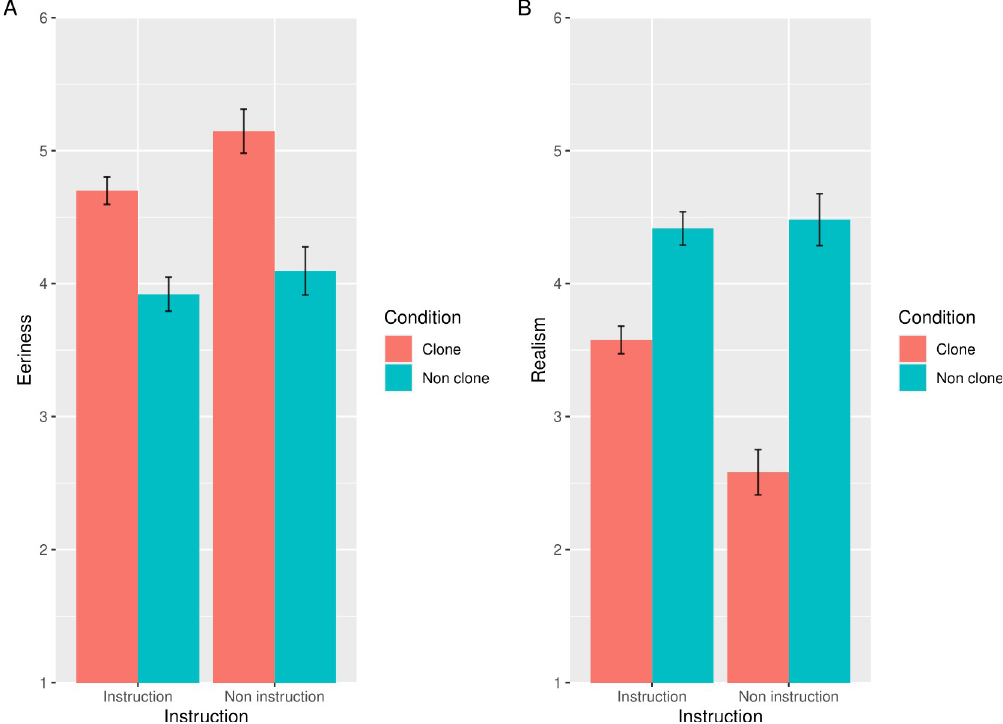
Fig 6. The results of the eeriness and realism evaluation in Study 4b. Error bars indicate the standard errors of the mean. The vertical axes indicate the mean eeriness (A), with realism scores (B) for images in each condition. The lower scores in realism indicate more improbable